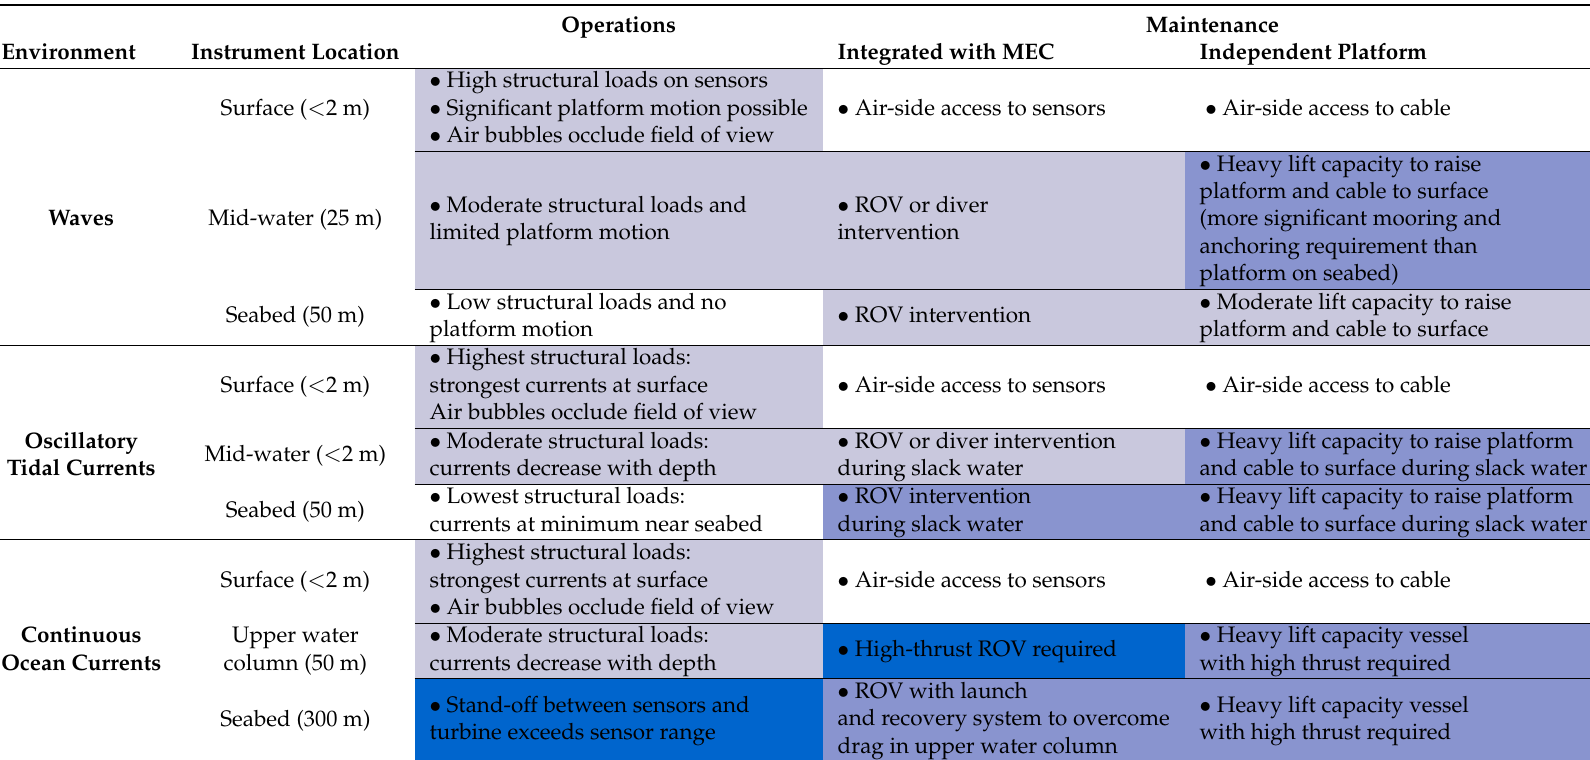
Table 3. Generalized operation and maintenance considerations wave wave, tidal and ocean current systems. Color progression from light to dark denotes difficulty. For waves, if water depth decreases (50 m nominal), wave orbital velocities are appreciable over relatively more of the water column. For oscillatory tidal currents, if water depth decreases (50 m nominal), currents near the seabed and at mid-water converge towards surface values. For continuous ocean currents, the region of significant currents extends to > 50 m